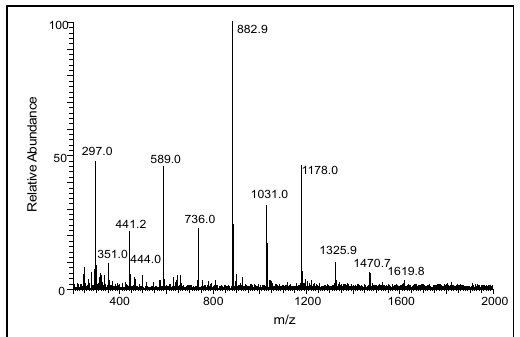
Figure 5. The average electrospray mass spectrum of the DHI reaction after 10 min of incubation at room temperature. Note the presence of clusters of ions corresponding to multiple oligomeric products at regular intervals of about 147 amu.